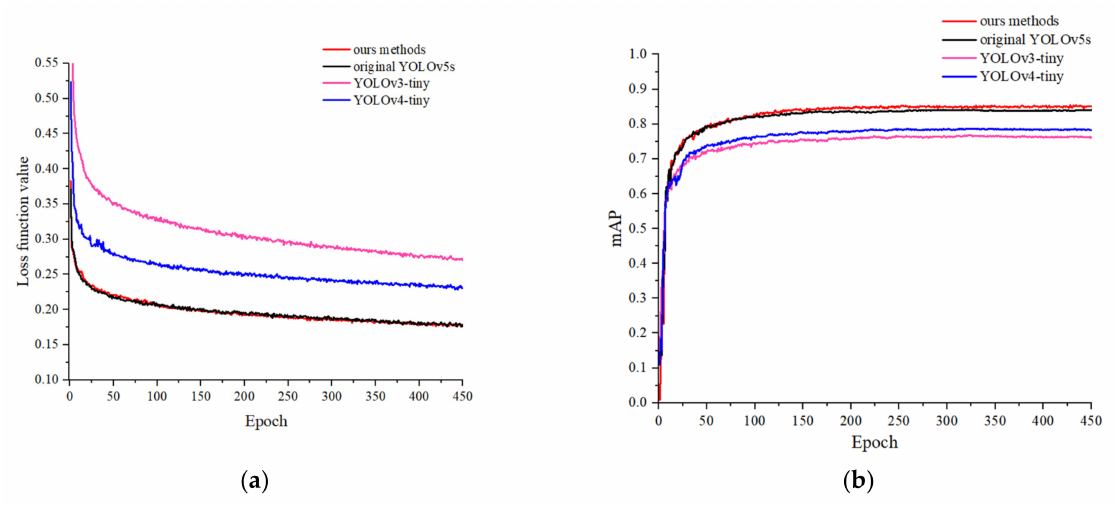
Figure 10. The training results of the four models are compared. ( a ) Loss curve. ( b ) mAP curve.